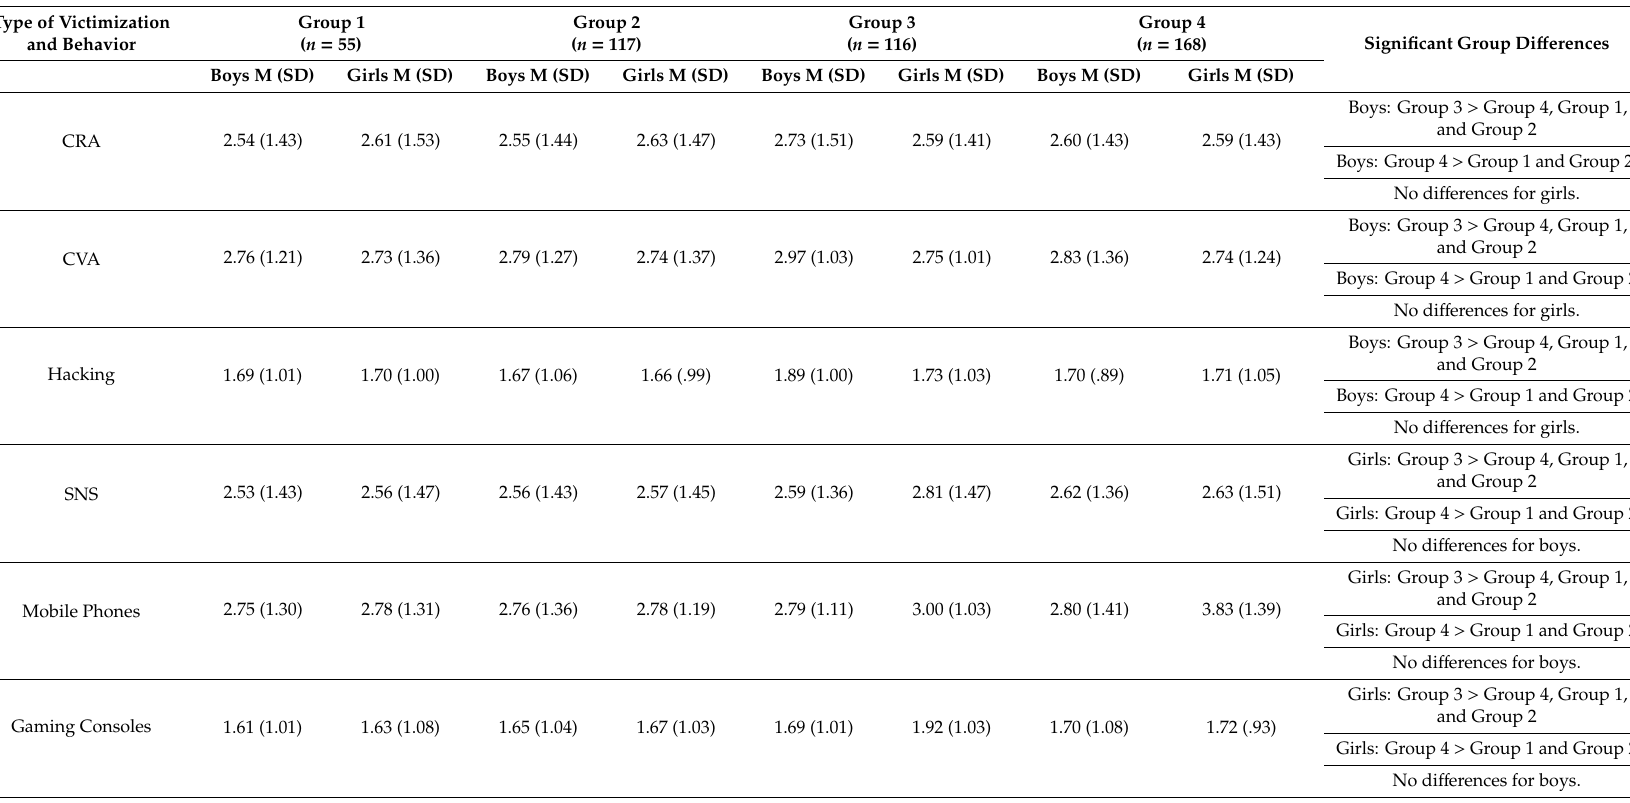
Table 2. Means and standard deviations for gender and groups based on gender stereotype traits based on cyber